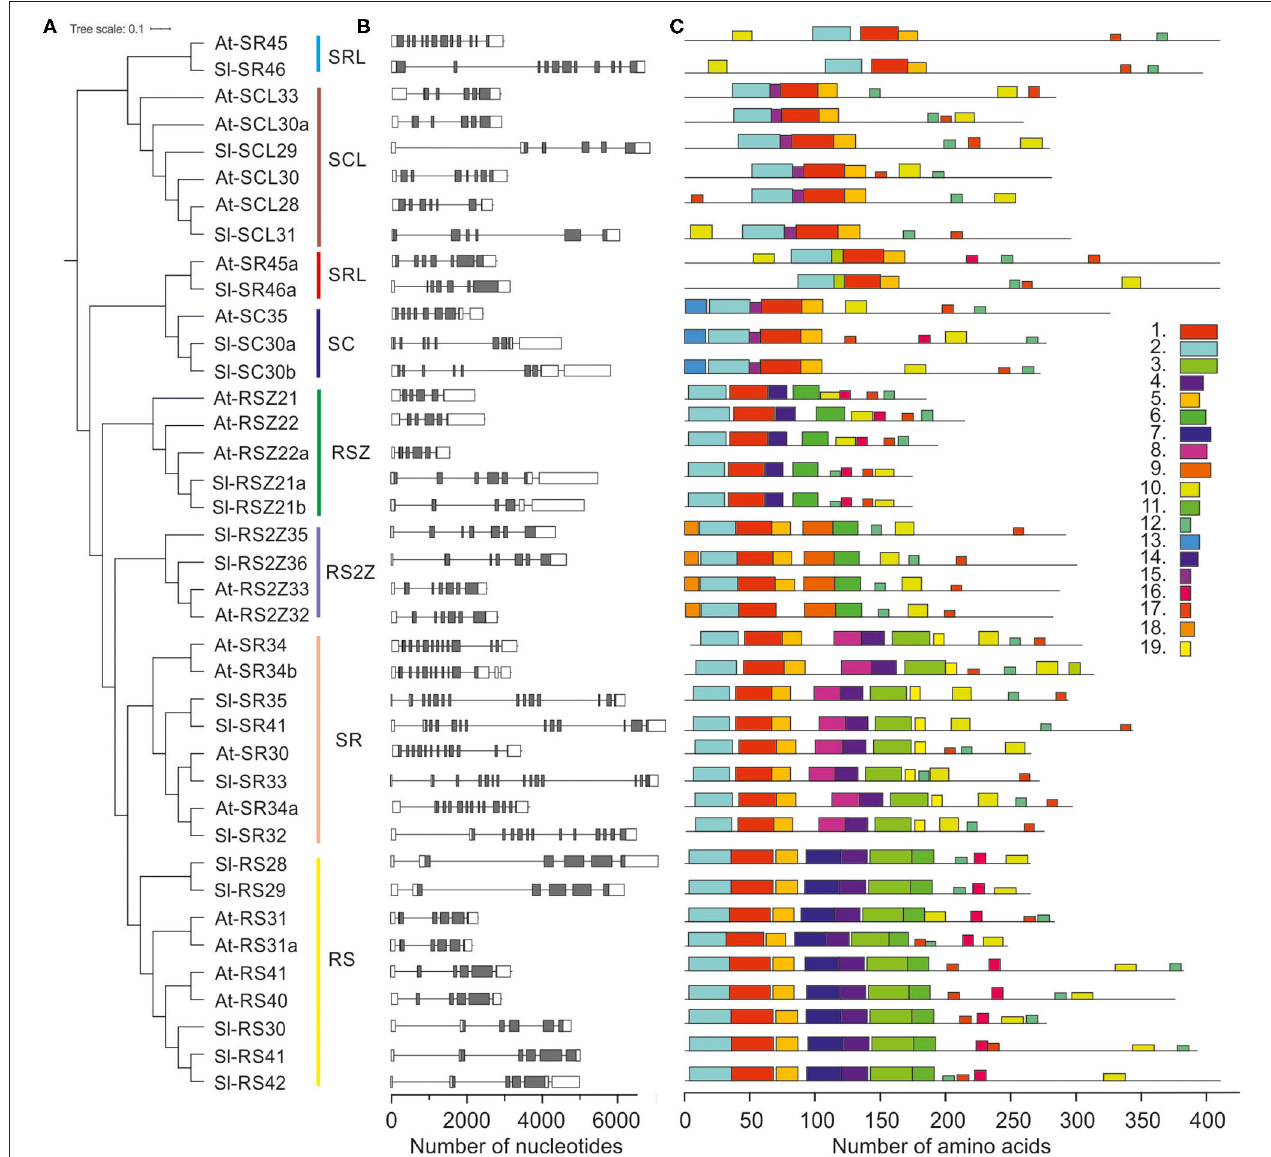
FIGURE 2 | Gene structure and amino acid motif occurrence in the Arabidopsis and tomato SR protein gene family. (A) Unrooted neighbor joining tree. (B) Intron (line)/exon (boxes) distribution of SR coding genes. Gray and white boxes indicate coding and untranslated regions, respectively. (C) Motifs of SR proteins. Details on the sequence of each motif are provided in Supplementary Figure 1